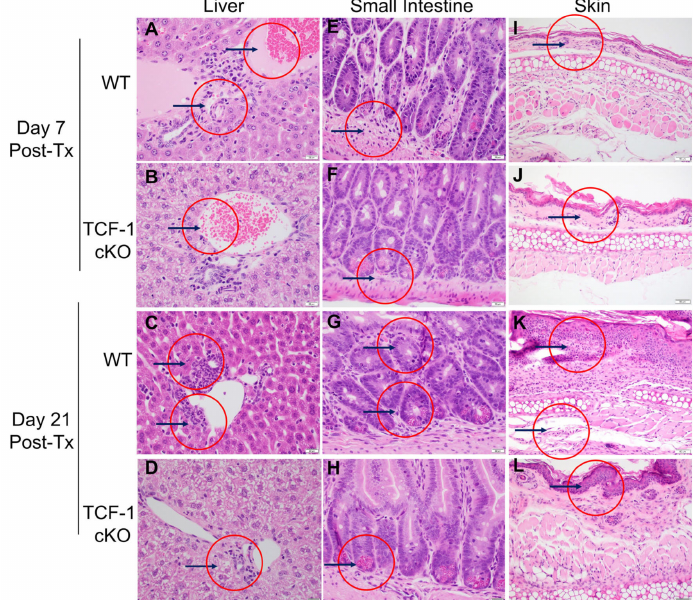
Figure 4. TCF-1 regulates CD4 T cells damage to GVHD target organs. We collected organs from mice allotransplanted, as described above. At day 7 and day 21 post-transplant, organs were taken from recipient mice for histology analyses. Skin, liver, and small intestine (SI) were sectioned, stained with H&E, and analyzed by a pathologist. Representative sections for each organ per group and timepoint are shown. Day 7—H&E liver image of recipient BALB/c mice transplanted with CD4 T cells from ( A ) WT mice and ( B ) TCF-1 cKO mice. Day 21—Liver of recipient mice transplanted with CD4 T cells from ( C ) WT mice and ( D ) from TCF-1 cKO mice. Day 7—SI of the recipient mice transplanted with CD4 T cells from ( E ) WT mice and ( F ) from TCF-1 cKO mice. Day 21—SI of the recipient mice transplanted with CD4 T cells from ( G ) WT mice and ( H ) from TCF-1 cKO mice. Day 7—Skin of the recipient mice transplanted with CD4 T cells from ( I ) WT mice and ( J ) from TCF-1 cKO mice. Day 21- Skin of the recipient mice transplanted with CD4 T cells from ( K ) WT mice and ( L ) from TCF-1 cKO mice. Arrows show lymphocyte infiltration and tissue damage One of the two experiments is